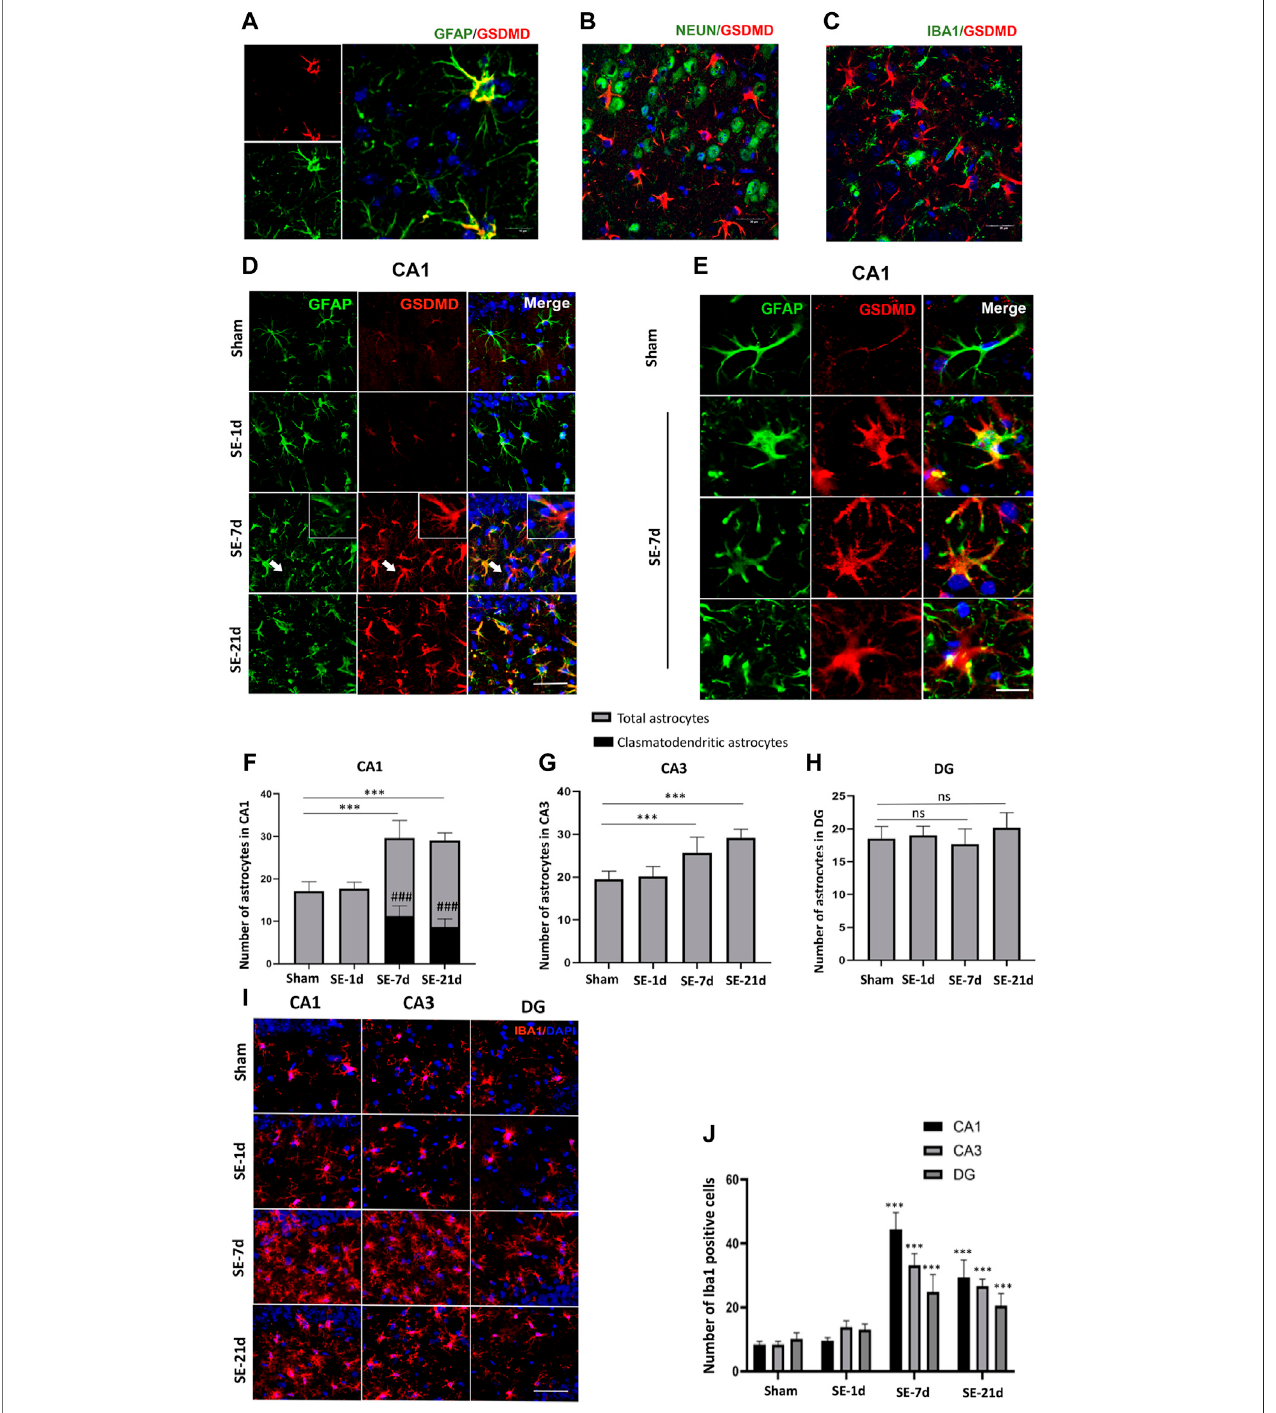
FIGURE2| Clasmatodendriticastrocytesco-labeledwithGSDMDafterSE. (A – C) RepresentativeimagesofGSDMD(red)/GFAP(green),GSDMD(red)/NeuN(green), andGSDMD(red)/Iba-1(green)staininginhippocampalslicesfrommiceatday7afterkainicacidinjection. (D) MicrophotographsofGSDMD(red)andGFAP(green)staining in the CA1 region ofthe hippocampus inthe sham, SE-1d,SE-7d,and SE-21d groups (bar= 50 µm). (E) TypicalGSDMD-positiveclasmatodendritic astrocytesinthe CA1 region of the hippocampus at 7 days after SE (bar = 12.5 µm). (F – H) Statistical analyses of the number of GSDMD-positive clasmatodendritic astrocytes and total astrocytesintheCA1,CA3,andDGregions( n =3ineachgroup,asterisksrepresentthetotalastrocytesincomparisonwiththeshamgroup,* p < 0.05,** p < 0.01,and*** p < 0.001; wellnumber represents the clasmatodendritic astrocytes in comparison with the sham group, ### p < 0.001). (I) Microphotographs of Iba1(red) staining in the CA1, CA3,andDGregionsofthehippocampusinthesham,SE-1d,SE-7d,andSE-21dgroups. (J) StatisticalanalysesofthenumberofIba1-positivecellsintheCA1,CA3,and DG regions ( n = 3 in each group, asterisks represent the comparison with the sham group, * p < 0.05, ** p < 0.01, and *** p < 0.001).